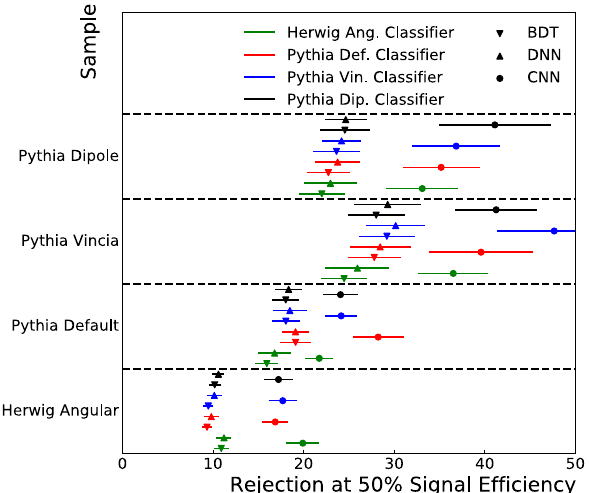
Fig. 6 The performance of classifiers as quantified by the rejection at a fixed signal efficiency of 50% when training on a given PSMC (color) and testing on the PSMC specified on the vertical axis. The symbols representthetypeofmodel(BDT,DNN,CNN).Theerrorbarsrepresent the standard deviation over the k folds